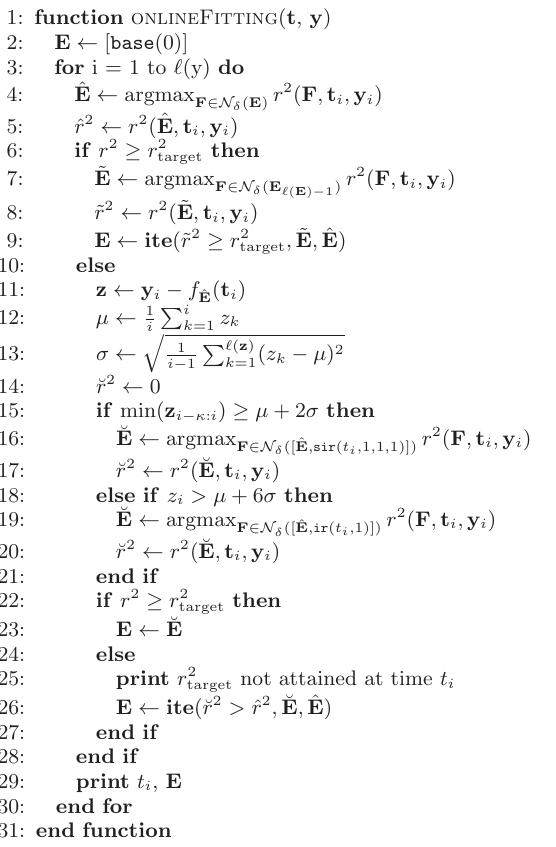
Robin Thicke BitTorrent